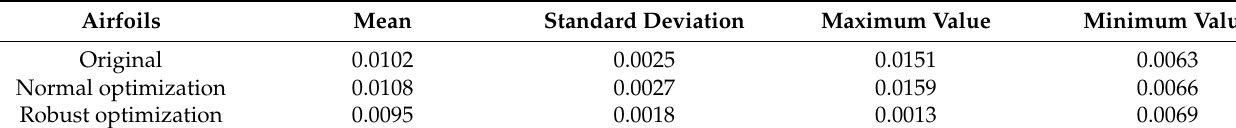
Table 5. Comparison of optimization results.